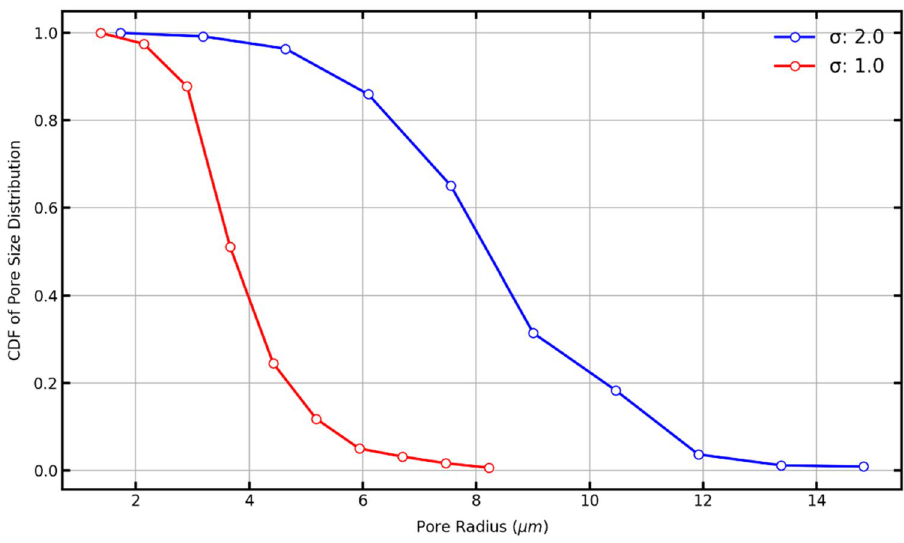
Figure 20. The cumulative density function of the pore size distribution of porous media with a sigma of 2.0 (blue line) and 1.0 (red line).